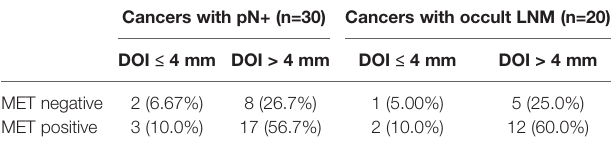
TABLE 6 | 2 × 2 tables showing the relationship between MET positivity and DOI status in cancers with pN+ (n=30) and cancers with occult LNM (n=20). Cancers with pN+ (n=30) Cancers with occult LNM